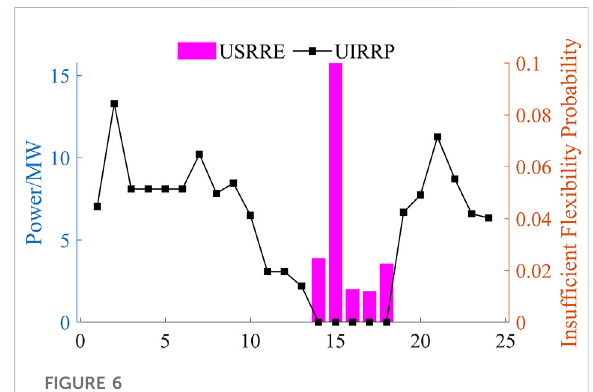
FIGURE 6 The USRRE&UIRRP results of HTSGS in Scenario